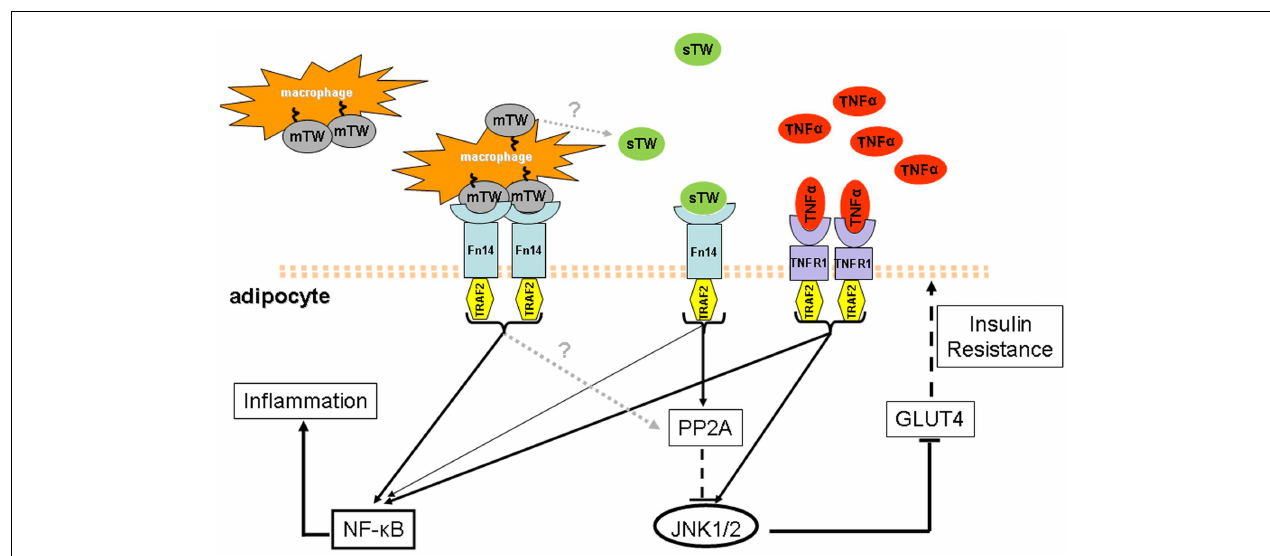
signal via similar TNFR-associated factors, including TRAF2. Amelioration of TNF α -induced insulin resistance by sTWEAK in obesity and T2D could be a consequence, at least in part, of its direct regulation of JNK1/2 phosphorylation, controlled by PP2A phosphatase which is known to negatively regulate cytokine signaling. PPA2 activation could thereby be linked to the protective role of sTWEAK during the development of insulin resistance.Thus it is tempting to speculate that in obesity and T2D, the increase of mTWEAK and the decrease of sTWEAK may help to maintain the pro-inflammatory effect of TNF α -driven